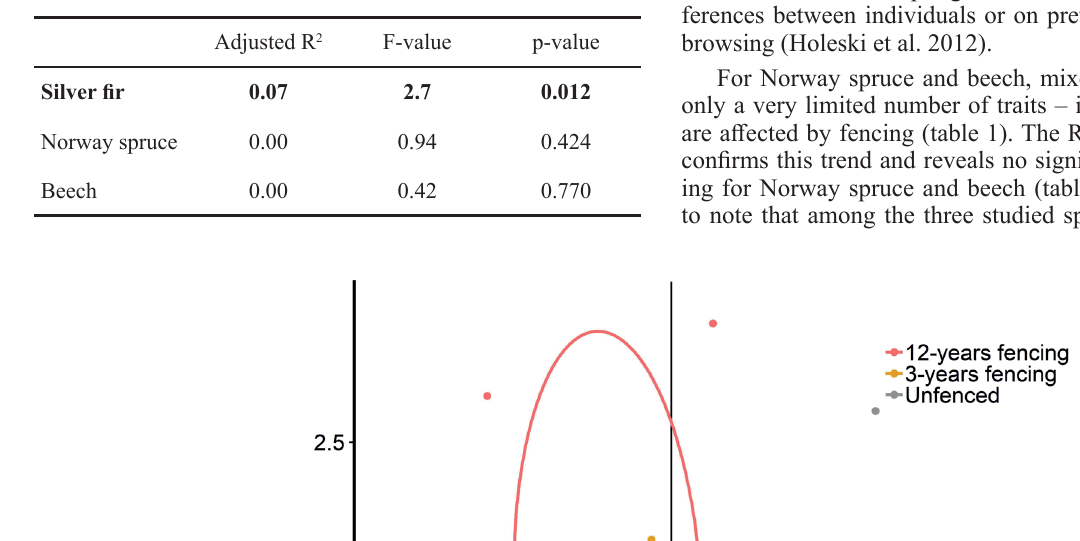
Table 2 – Adjusted R 2 , F-values and p-value obtained from the RDA testing the effect of the fencing treatment on the three studied species functional traits [traits ~ Fencing + Condition( experimental unit )]. RDA was performed for each species with SLA, C:N ratio, N, P, phenolic content, maximum stress and Young’s modulus as response variables. F-values and p-values were obtained with the Monte Carlo permutation test (n = 999, α = 0.05). Bold value indicates a significant fencing effect.